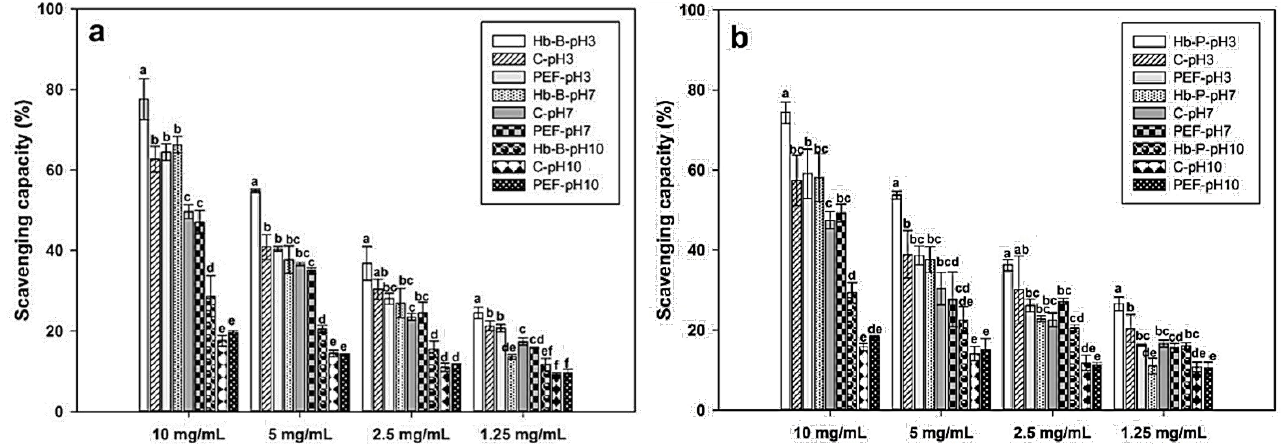
Figure 5. DPPH-scavenging activities of bovine ( a ) and porcine ( b ) hemoglobin hydrolysates that were untreated (C, control) and treated with PEFs at different concentrations. Hb-B and Hb-P indicate native bovine and porcine hemoglobin, respectively. Values with different lowercase letters within the same concentration are significantly different (Tukey test at 5%).